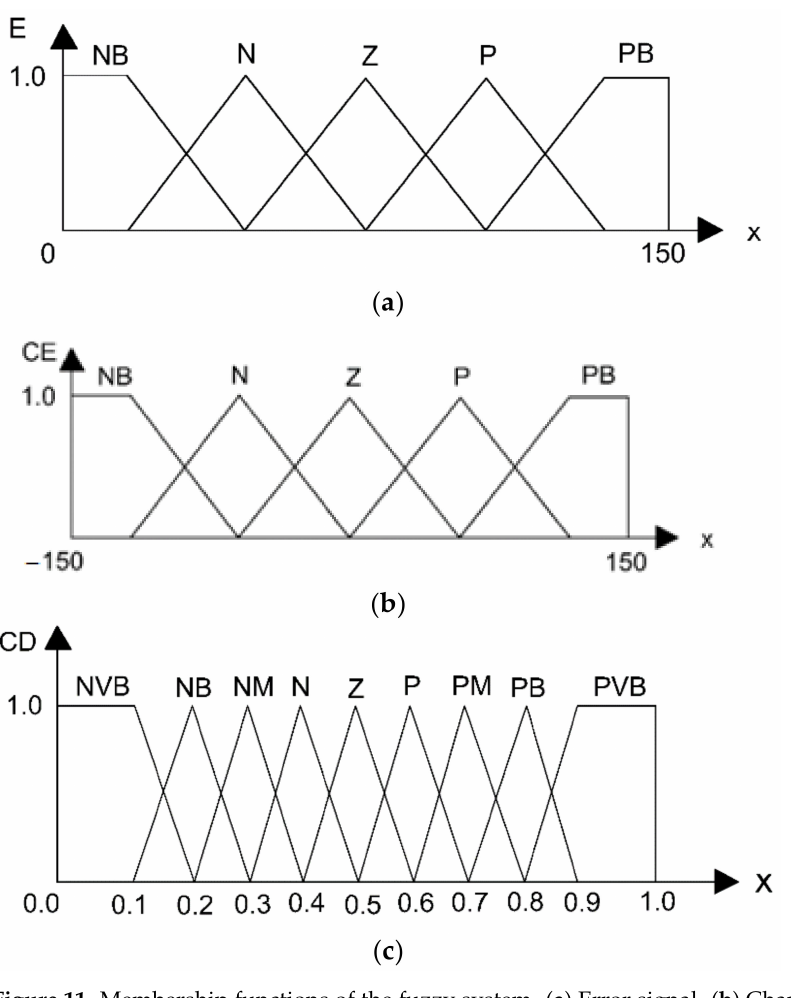
Figure 11. Membership functions of the fuzzy system. ( a ) Error signal. ( b ) Change of error signal. ( c ) Change of duty cycle.